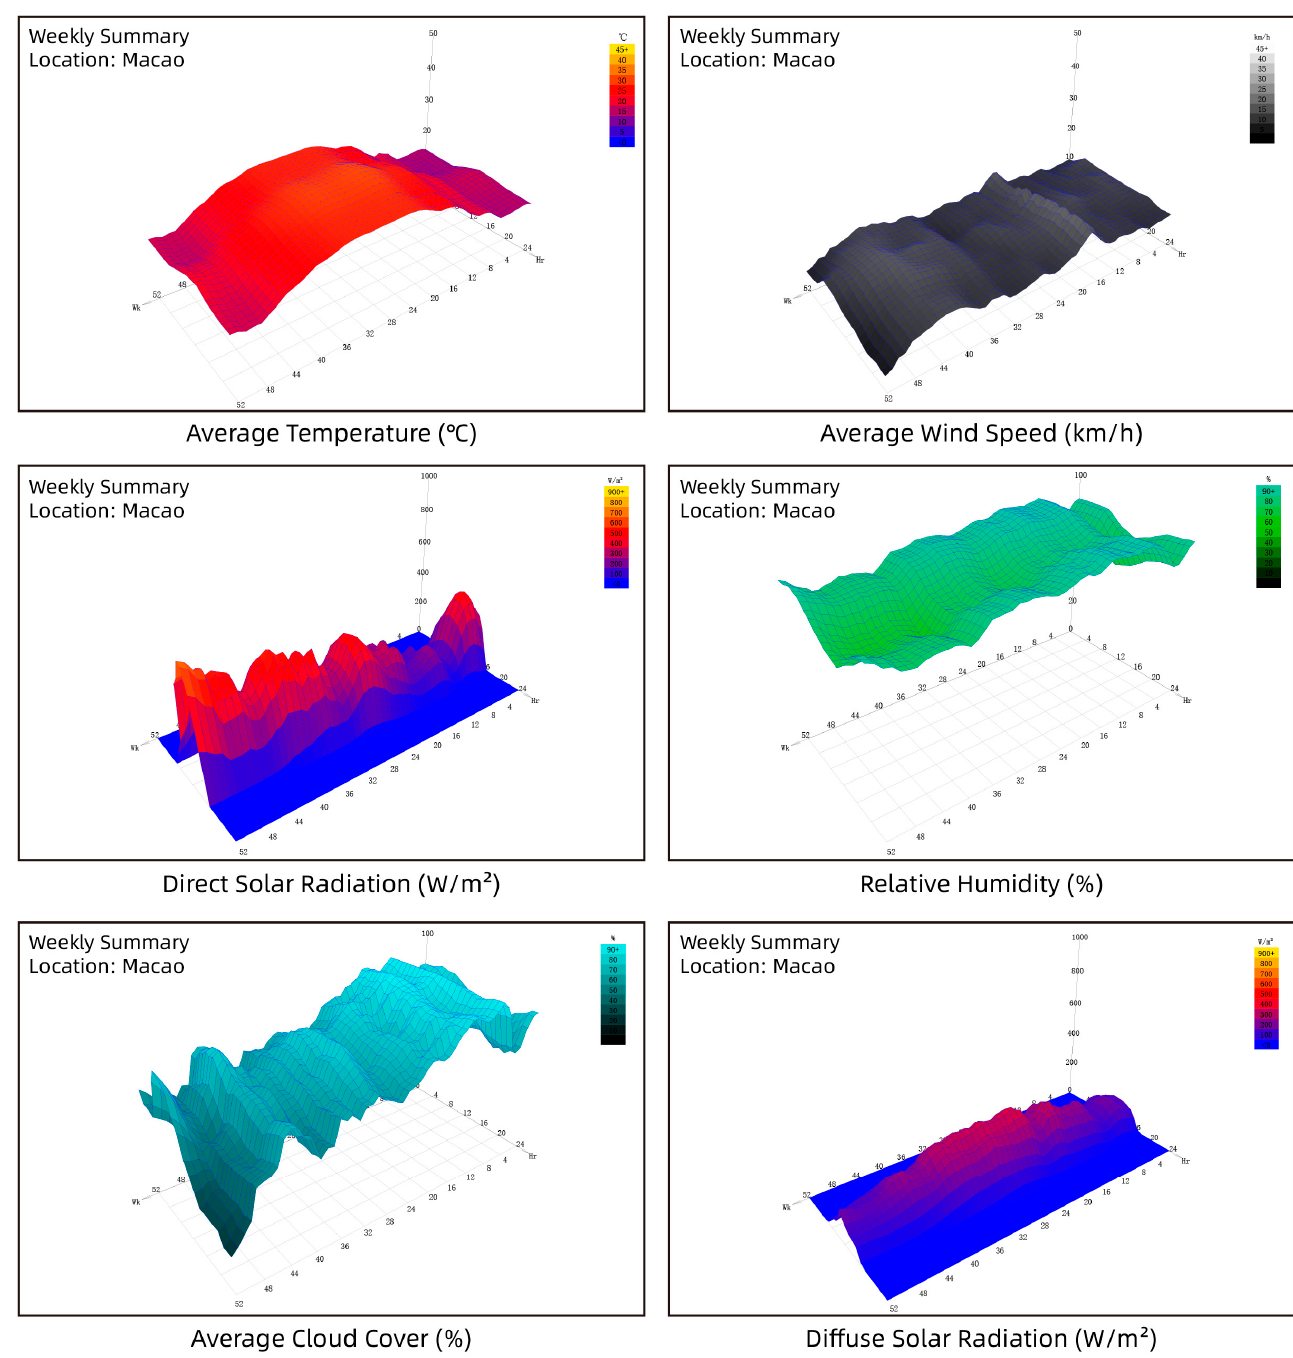
Figure 1. Climatic Conditions of Macau. (Image Source: drawn by the author).